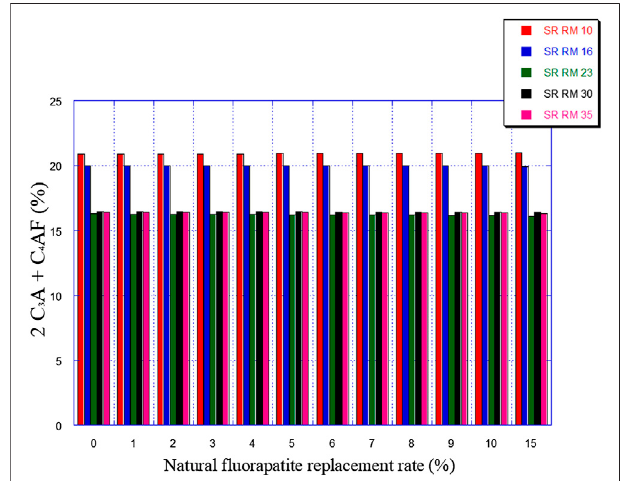
FIGURE 7 | Expected C 3 A amounts variation in function of the natural fl uorapatite replacement. FIGURE 8 | Expected 2C 3 A + C 4 AF amounts variation in function of the